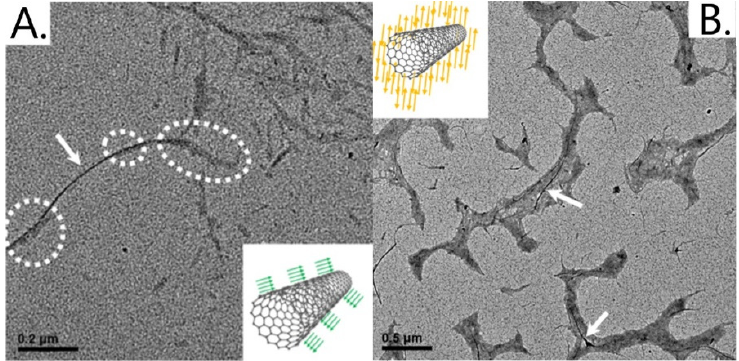
Figure 3. TEM micrograph of SWCNT/NCC hybrids. ( A ) Type I NCC; ( B ) Type II NCC. Arrows show SWCNTs, and dotted circles show cellulose nanocrystals. Insets: Parallel and antiparallel NCC fibers [38]. Figure adapted with permission from [38] Copyright © 2019 American Chemical